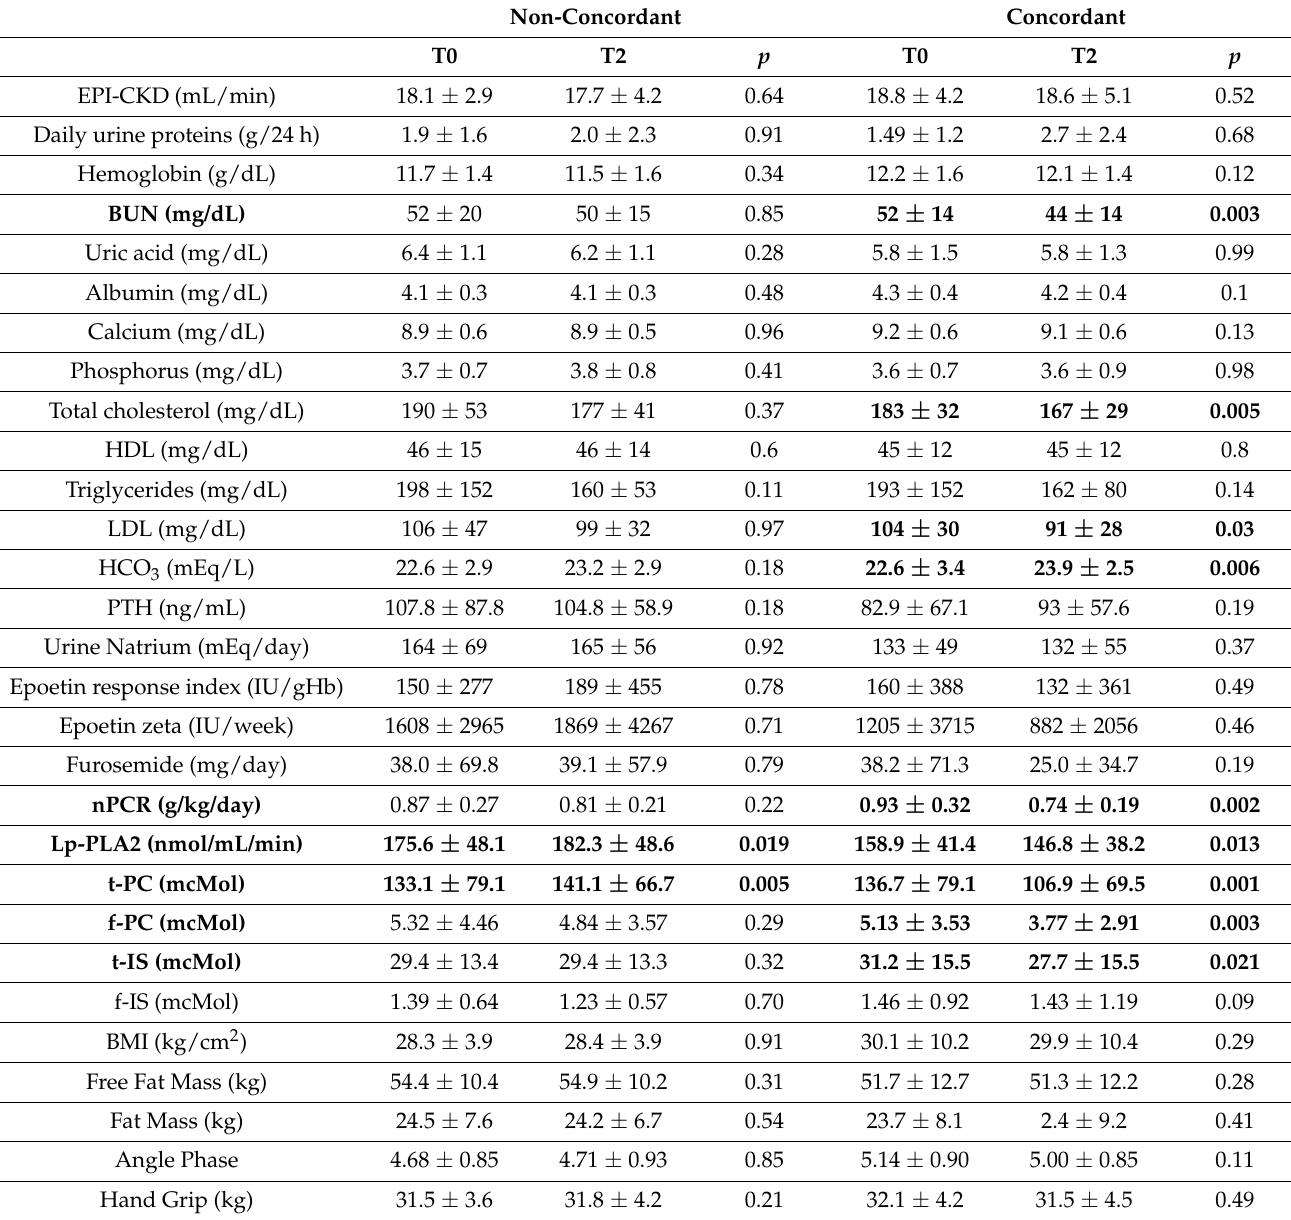
Table 3. Comparison between biochemical and nutritional parameters and pharmacological therapy in non-concordant and concordant